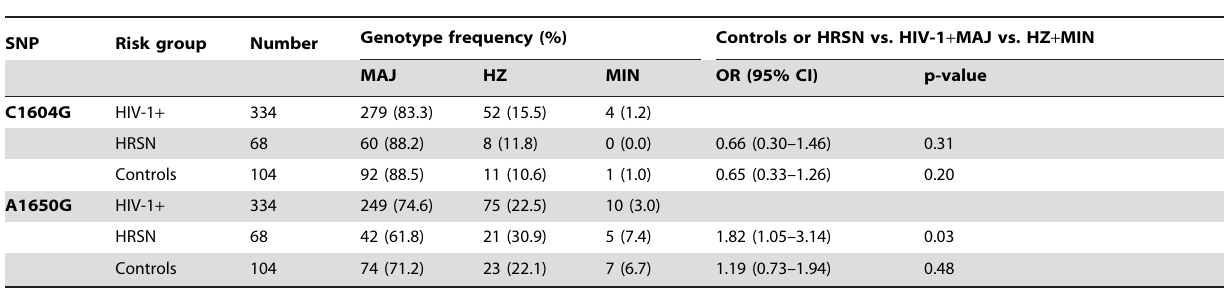
Table 1. Genotype distributions of the CypA SNPs C1604G and A1650G and risk for HIV-1 infection.